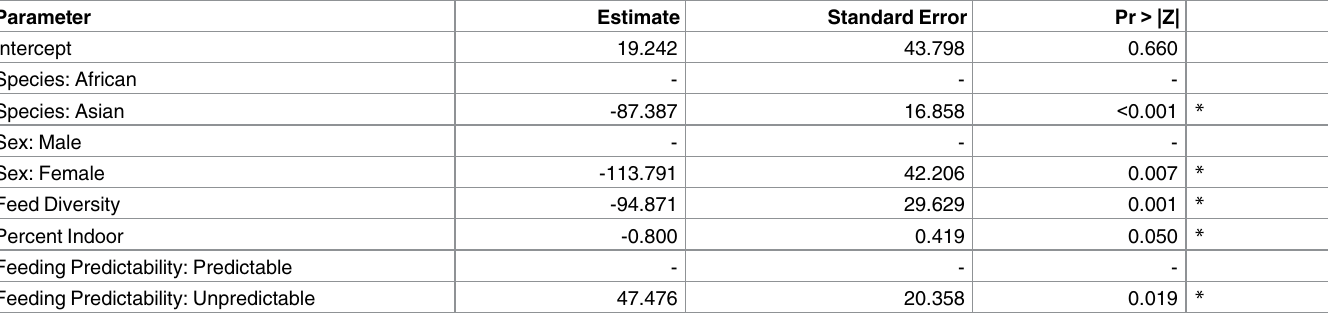
Table 13. Predictive model describing primary variables associated with mean